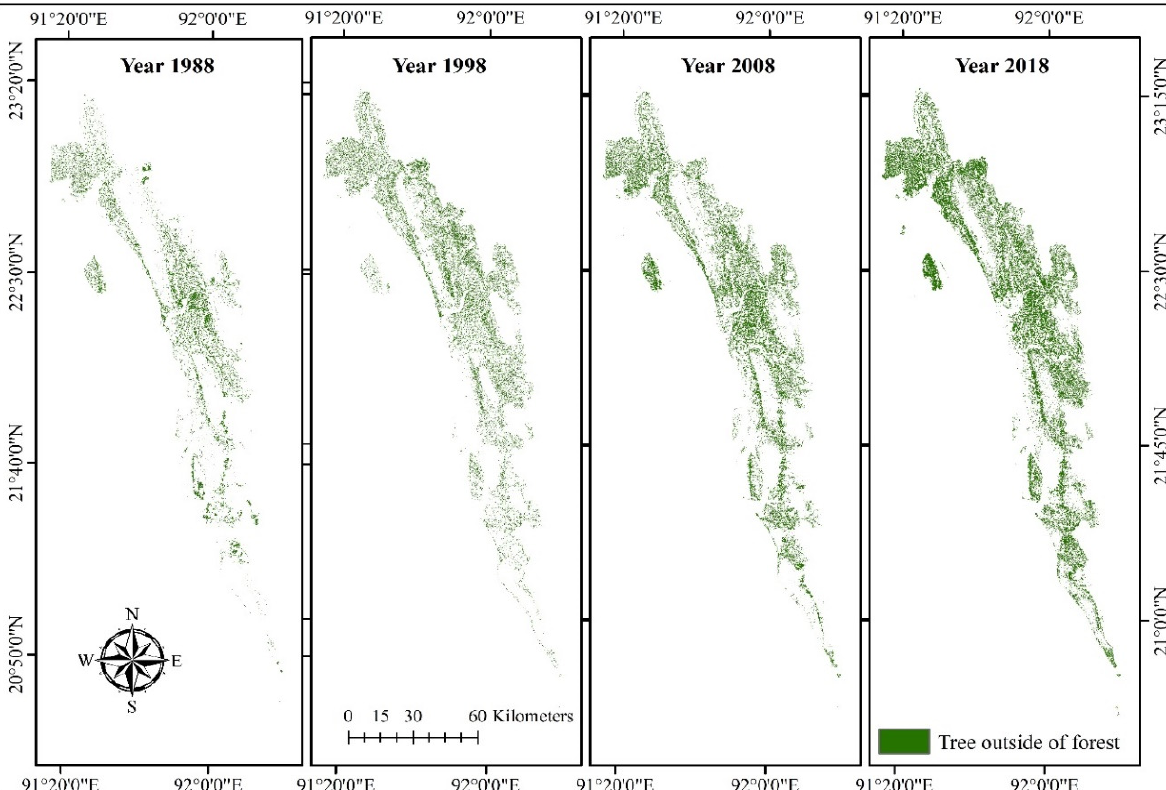
Figure 5. Supervised image classification of the eastern coastal zone depicting the increasing trend of TOF and the other land use and land cover.